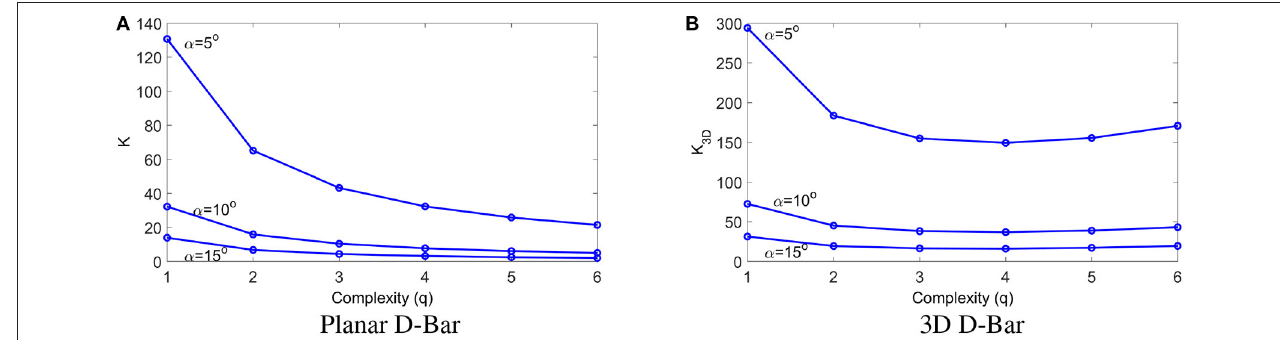
is reasonable since as the angle and complexity decreases, the